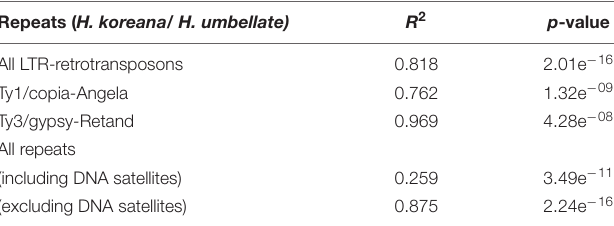
TABLE 3 | Linear model regressions of repeat contents with genome size variation among H. koreana and H. umbellata . Repeats ( H. koreana/ H. umbellate) R 2 p